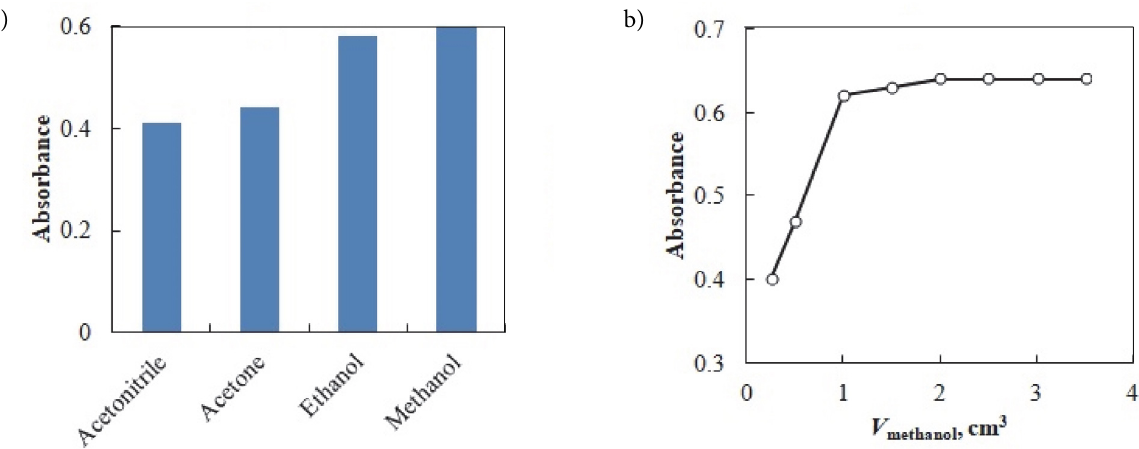
Fig. 4. Effect of type (a) and volume (b) of dispersive solvent on extraction: 3.33 × 10 –5 mol/dm 3 of DHDPhB, 6.67 × 10 7 mol/dm 3 of Cu(II), V Chloroform = 1 cm 3 , λ = 570